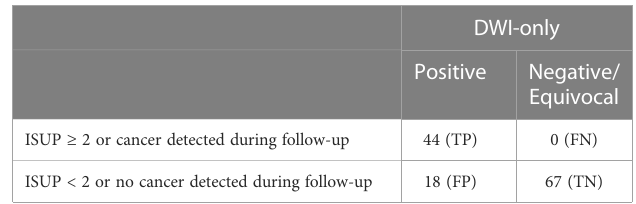
TABLE 3 2x2 contingency table for detecting clinically signi fi cant prostate cancer for the prospective readers.